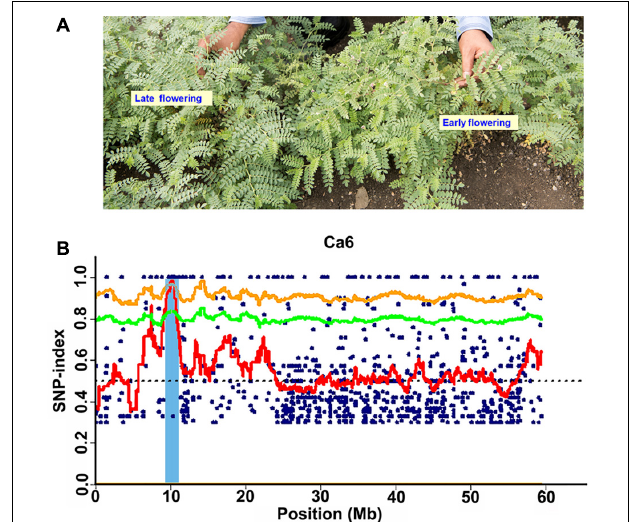
FIGURE 1 | Phenotypic variation for flowering time and identification of candidate genomic region using MutMap approach. (A) Representative picture showing the variation in flowering in the MutMap population developed crossing ICC 4958-M3-2828 × ICC 4958 (wild). (B) A genomic region on Ca6 x-axis indicates the physical position of the chromosome, and the y-axis indicates the average SNP-index in a 2 Mb interval with a 10 kb sliding